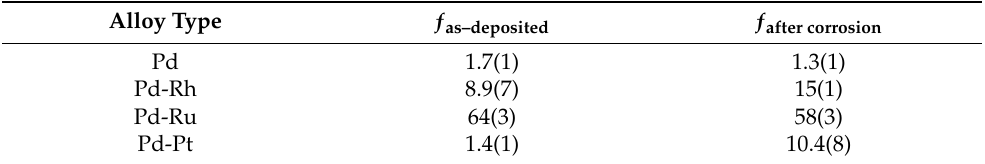
Table 3. Surface roughness factor of the Pd and Pd-binary alloys before ( ƒ as–deposited ) and after corrosion ( ƒ after corrosion